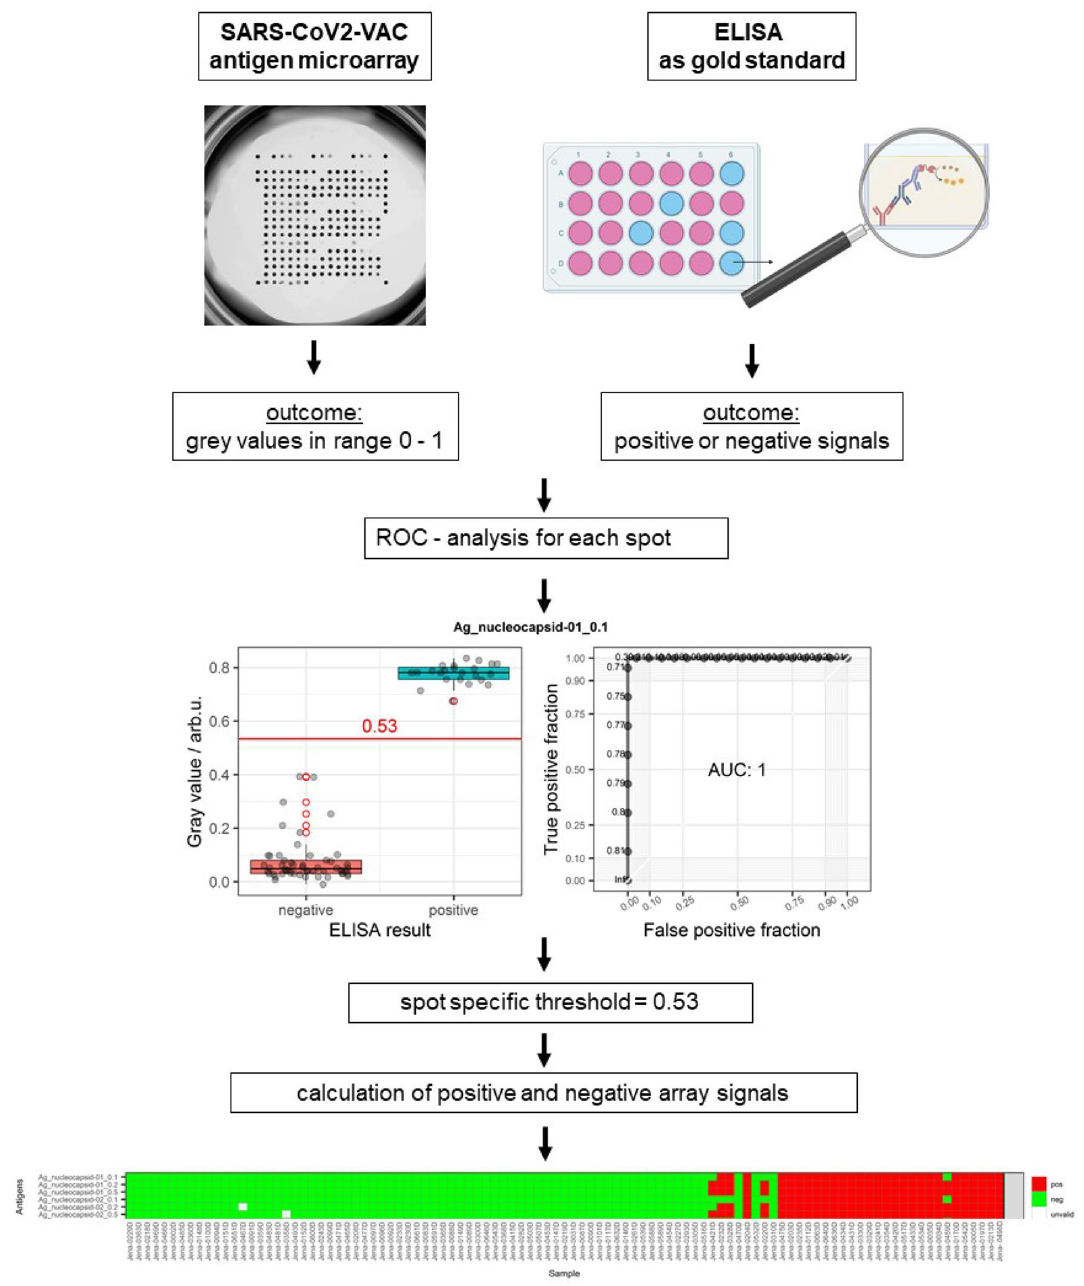
Figure 5. The verification of the new SARS-CoV2-VAC microarray was carried out according to the steps indicated in the